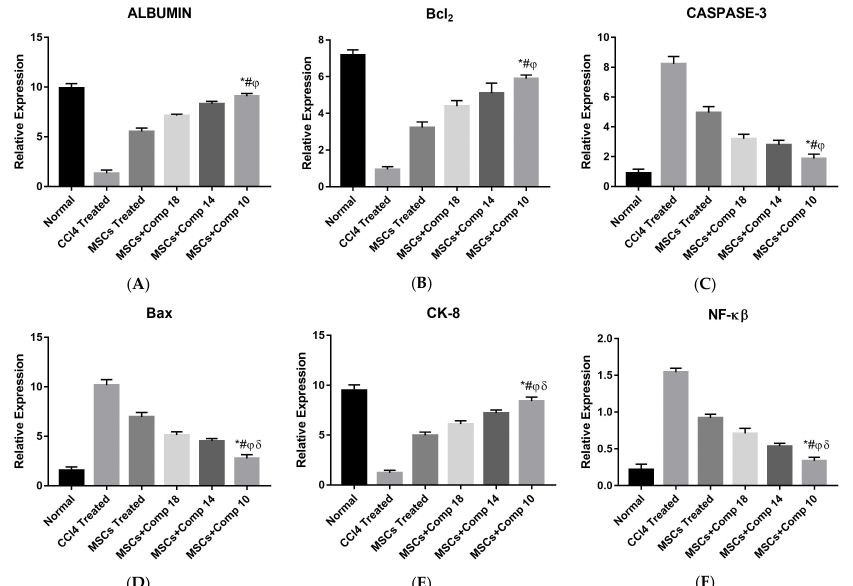
Figure 7. Real ‐ time PCR analysis liver tissue after MSCs + compounds transplantation . Hepatic marker genes (albumin, CK ‐ 8) and anti ‐ apoptotic ( Bcl ‐ xI and BCl 2 ) were increased and apoptotic ( BAX , caspase ‐ 3, NF ‐ k β and TNF ‐α ) genes were decreased 2 weeks after transplantation. p < 0.05 for MSCs + compounds ‐ treated rats, compared to CCl 4 ‐ treated and